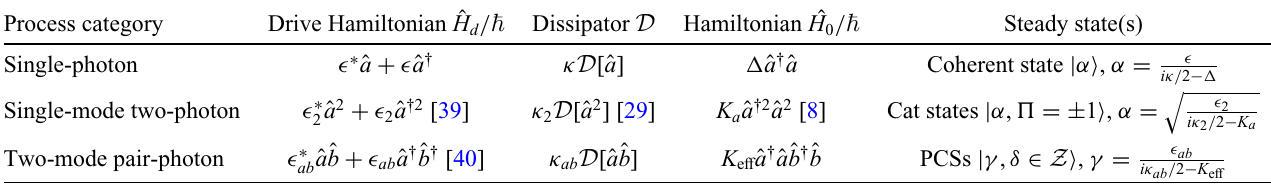
TABLE I. A comparison of multiphoton steady states under driven dissipative processes constructed with different operators, ˆ o = ˆ a , ˆ a 2 and ˆ a ˆ b . For each of the three cases, we consider cavity dynamics following the master equation ˙ ρ = − i written in the rotating frame of the drives, where D is the Lindblad superoperator with ˆ o as its jump operator. In the textbook example of the driven damped quantum oscillator, the mode detuning (cid:7) and single-photon loss κ jointly counter the driving force and determine the complex amplitude of the unique steady state of the system. In two-photon dynamics, the complex amplitude of the steady states is analogously determined by the one-mode or two-mode squeezing drives countered by the corresponding two-photon loss rates and confining Kerr Hamiltonian [38]. Our experiment produces PCSs under both dissipative and cross-Kerr Hamiltonian confinement, with the effective cross-Kerr K eff a few times stronger than the pair dissipation κ ab . Notably, two steady states exist (with even or odd photon- number parity (cid:9) ) for the case of cat-state stabilization, while there are infinitely many steady states (with different photon-number difference δ ) for the case of stabilizing PCSs.